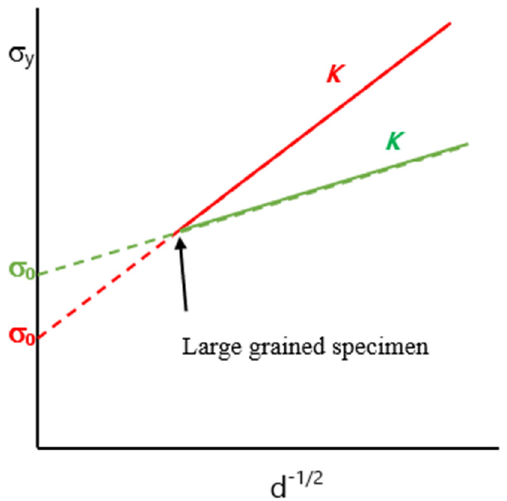
Figure 1. Schematic Hall–Petch plot for two materials that have the same yield strength, σ y , for large-grained samples but different Hall–Petch slopes, k , leading to different values of the lattice resistance, σ 0 .